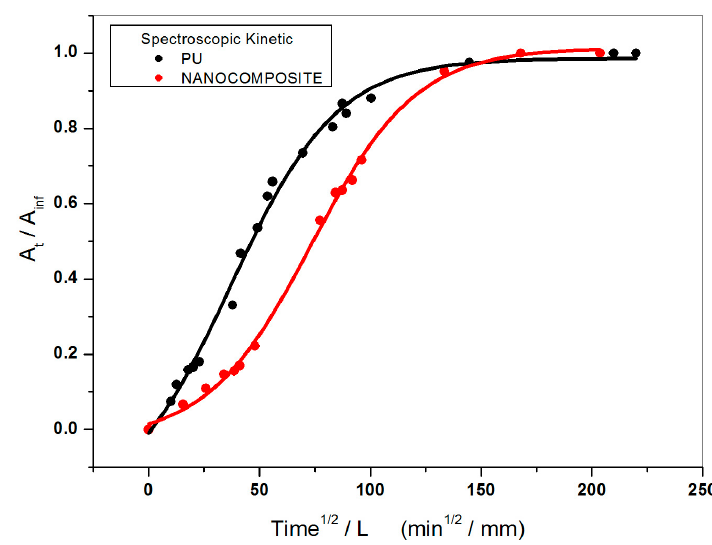
Figure 6. Fick’s curves plotted by spectral data for plain poly (carbonate urethane) and TiO 2 /poly (carbonate urethane) nanocomposite systems.